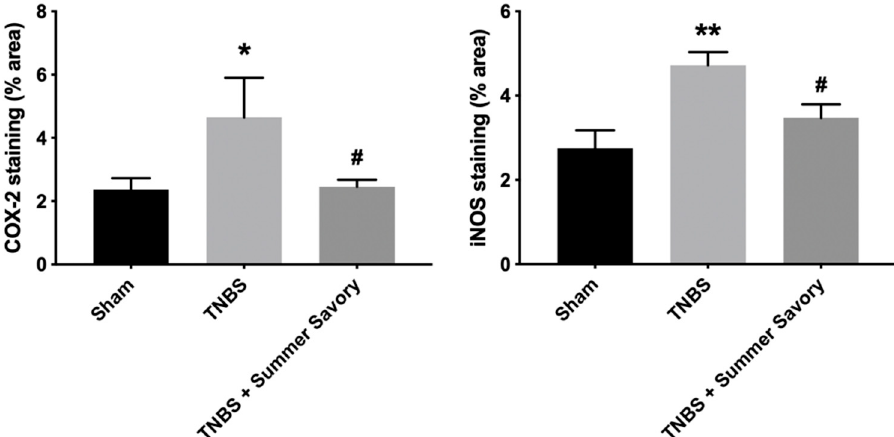
Figure 10. Evaluation of COX-2 and iNOS activation in the TNBS colitis model reveals that specimens from TNBS colitis group exhibits severe expression of COX-2 and iNOS (brown staining, arrow), while specimens from the animals treated with Summer Savory extract exhibited no expression of COX-2 and iNOS. Sham Group ( n = 6); EtOH Group ( n = 6); TNBS + EtOH Group ( n = 10); TNBS + Summer Savory Group ( n = 10). Original magnification ×100. Scale bar equals 50 µm.